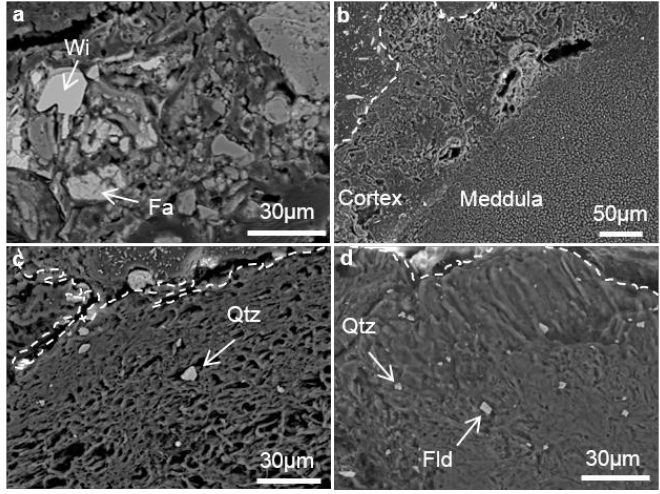
Figure 3. Back-scattered electron images of thallus containing fragments. Distances from substrata increase from ( a ) to ( d ) every 2 mm. ( a ) is the section where 100 μm high from slag; ( b ) and ( c ) are the section of thallus; ( d ) is the section of apothecium. The broken lines indicate thallus-resin interfaces. Wi: willemite; Fa: fayalite; Qtz: quartz; Fld: